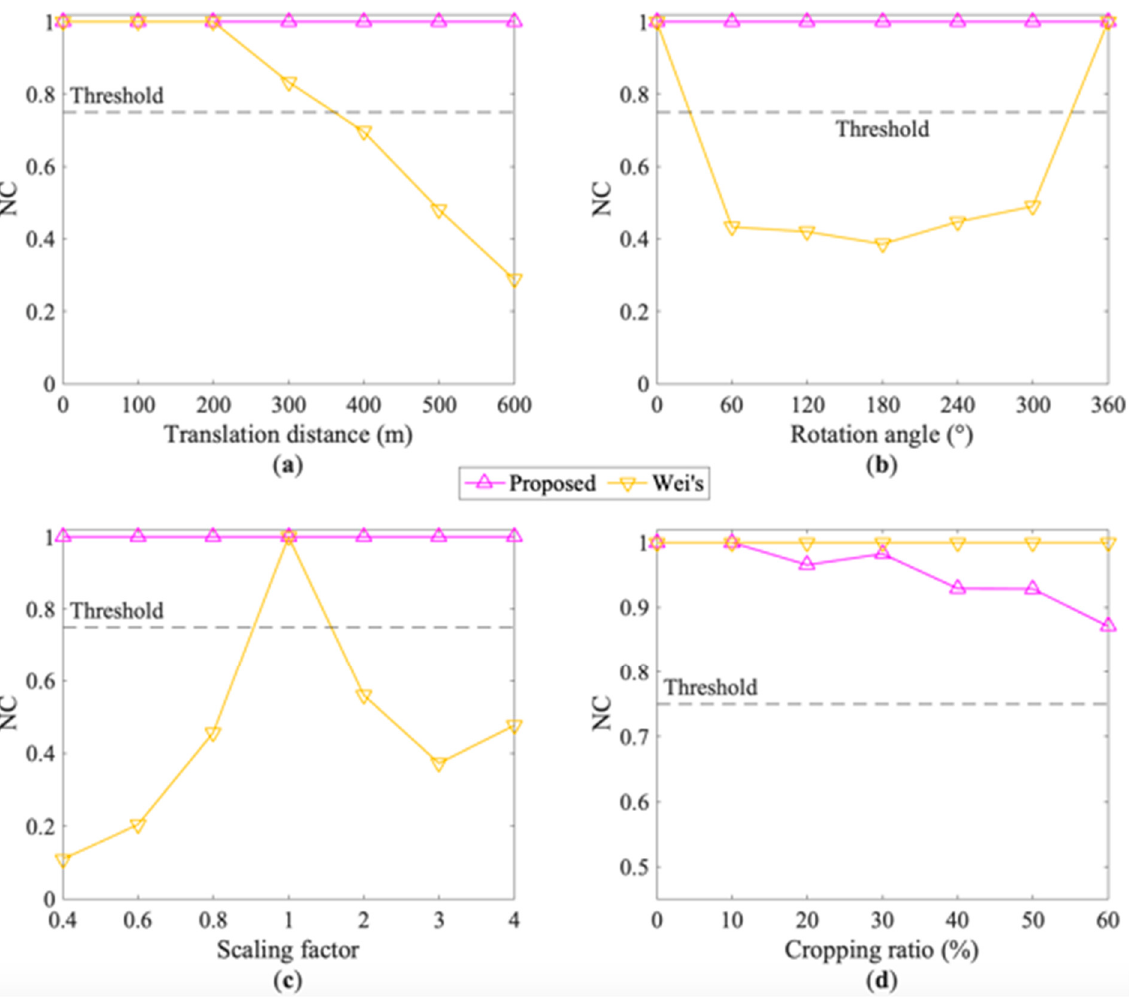
Figure 6. The results after attacks. ( a ) The results of translation attacks; ( b ) the results of rotation attacks; ( c ) the results of scaling attacks; ( d ) the results of cropping attacks.